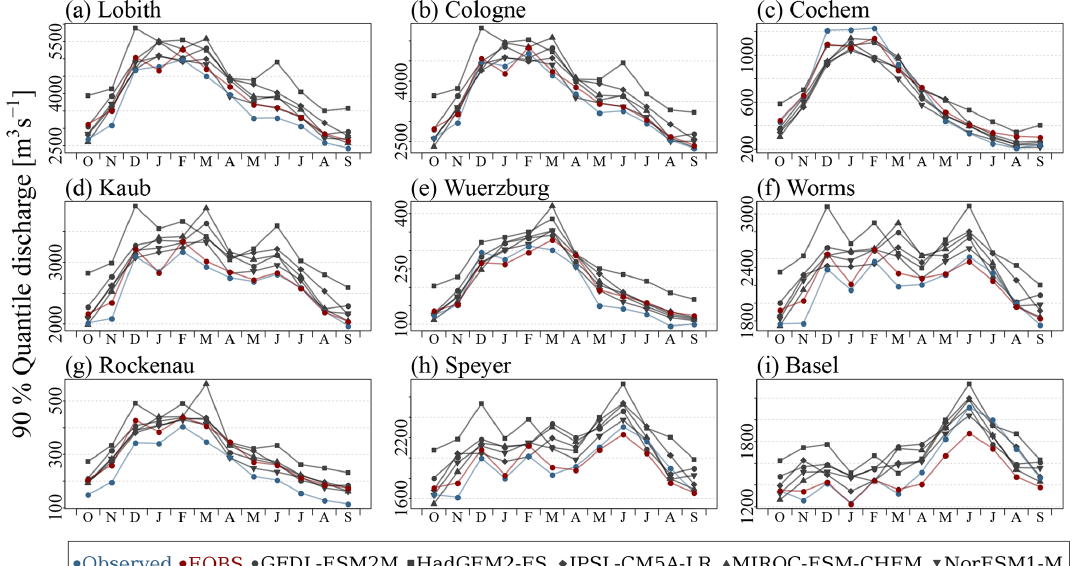
Figure C1. Streamflow quantiles (90%) for every month of the year based on daily resolution observations and simulations using E-OBS- based meteorological forcing and climate model data from the ISI-MIP project for all validation gauges (Fig. 2). Time frame investigated: